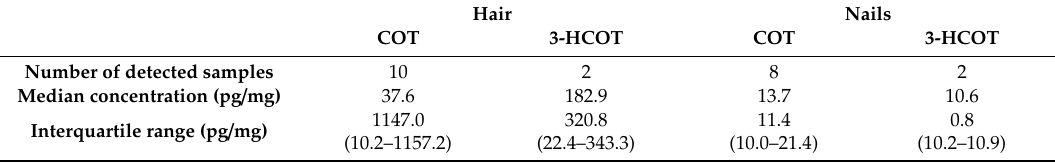
Table 2. Summary of monitoring results of nicotine metabolites in 26 infant samples.